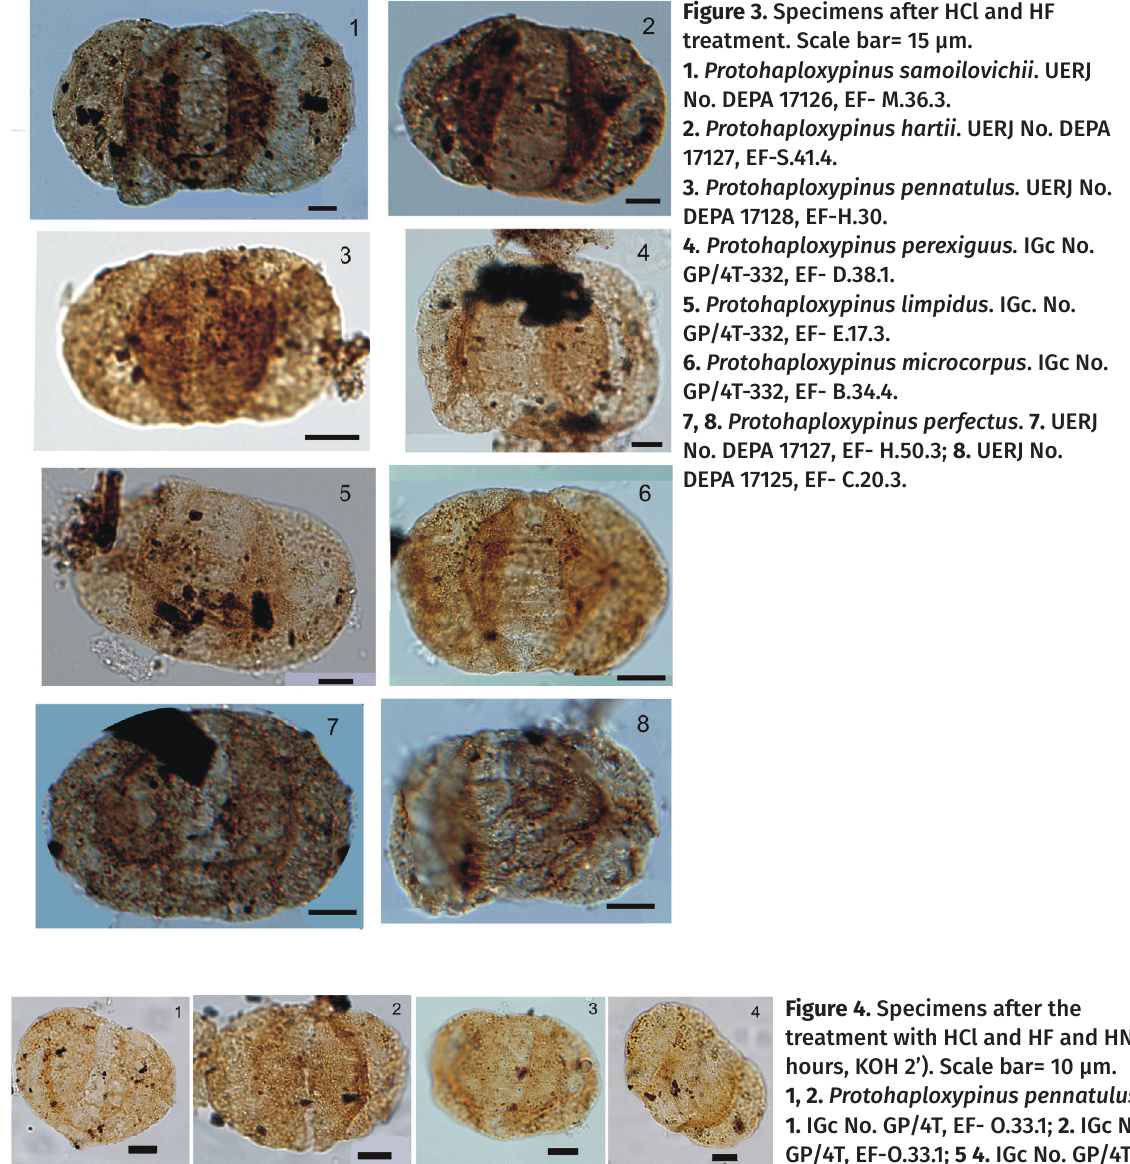
Figure 3. Specimens after HCl and HF treatment. Scale bar= 15 µm.